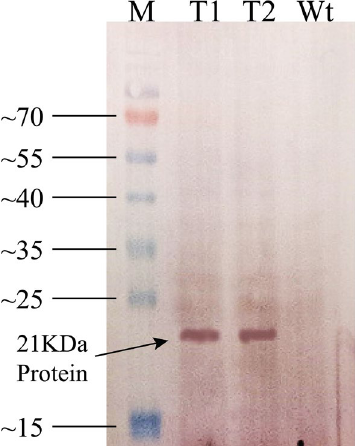
Fig. 4 Western blot analysis of extracted crude protein. Lane1 : Thermofisher prestained protein ladder (cat no: 26617) . Lane 2 and lane 3: protein samples T1 and T2 . Lane 4: wild type TN72